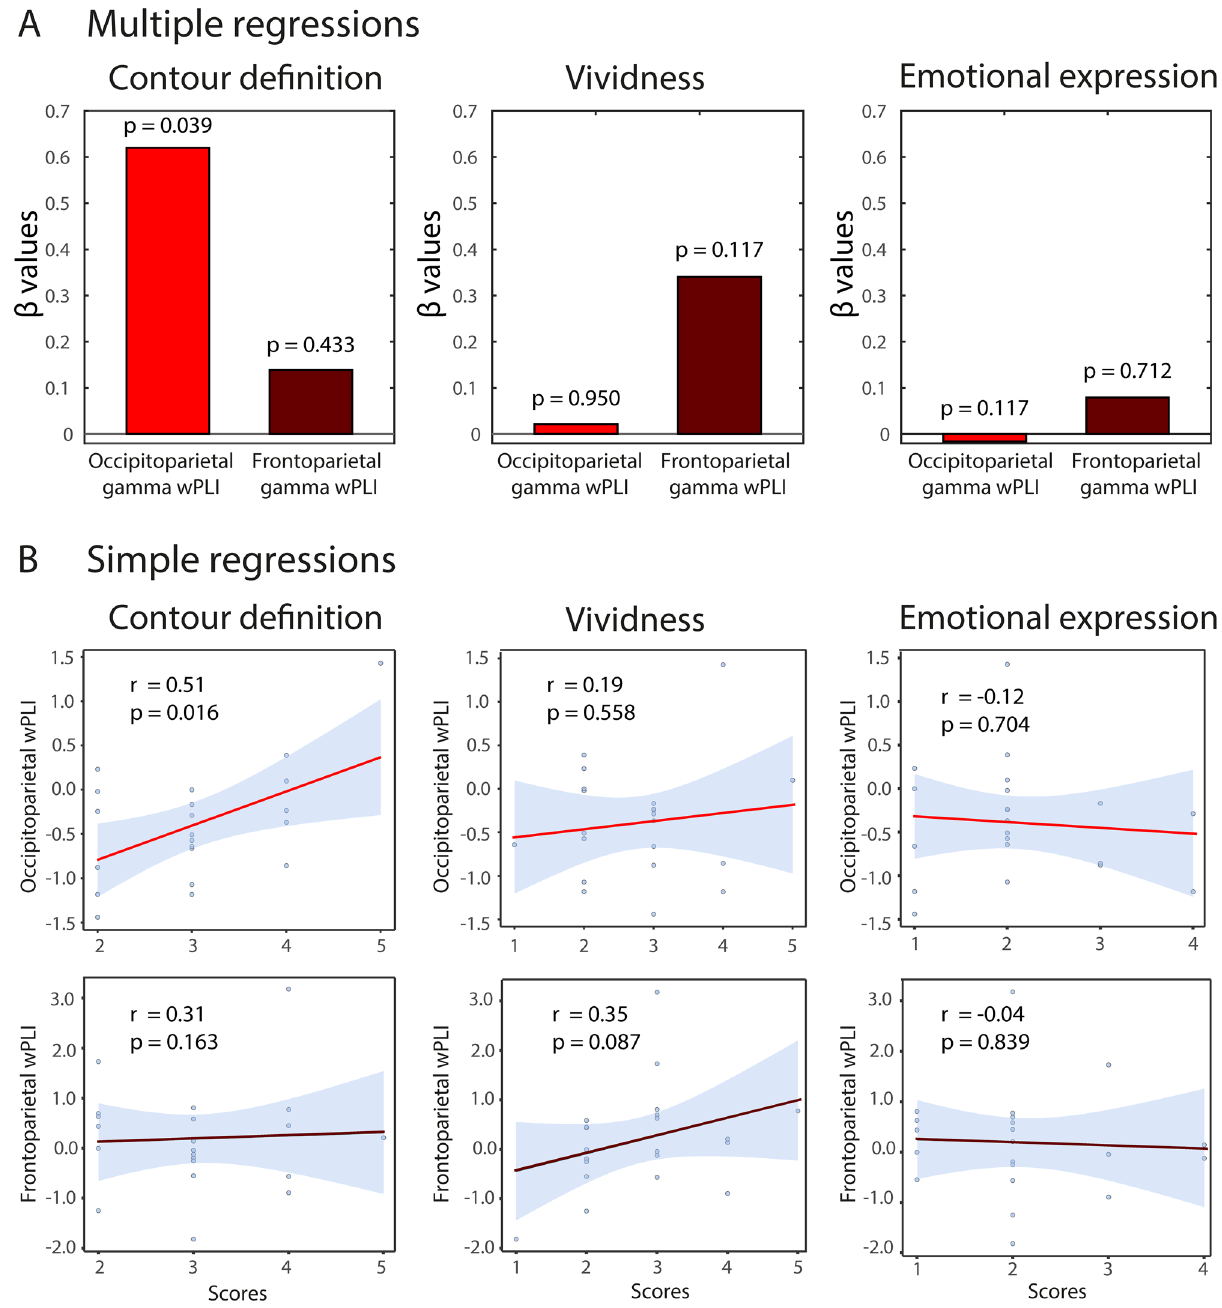
Figure 5. Multiple and single regressions between wPLI and behavioural scales. ( A ) Beta coefficients for three separate multiple regressions using Likert scales (vividness, contour definition, and emotional expression) as an outcome variable and frontoparietal and occipitoparietal wPLI as predictors. ( B ) Pearson’s correlation between frontoparietal and occipitoparietal wPLI values and the corresponding scale